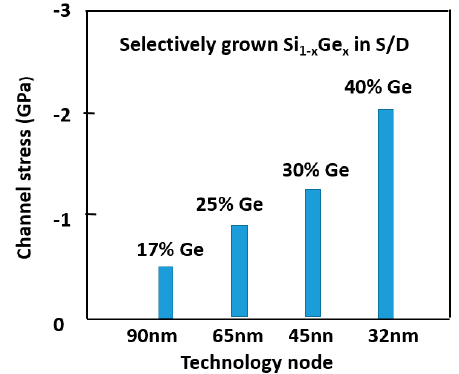
Figure 6. The evolution of Ge content in SiGe S/D and stress created in channel for different technology nodes. Appl. Sci. 2017 , 7 , 1047